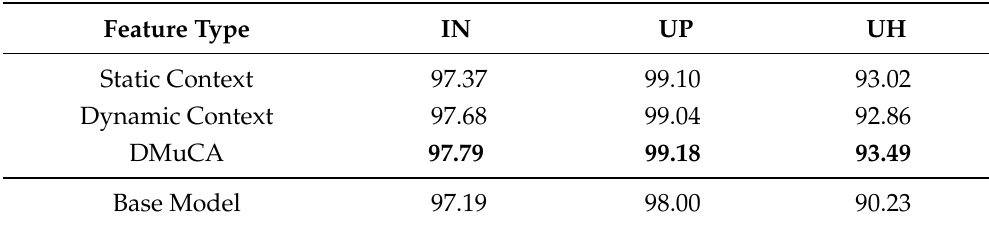
Table 5. Effects of different methods on contextual information exploration (OA%). The best results are highlighted in bold font.